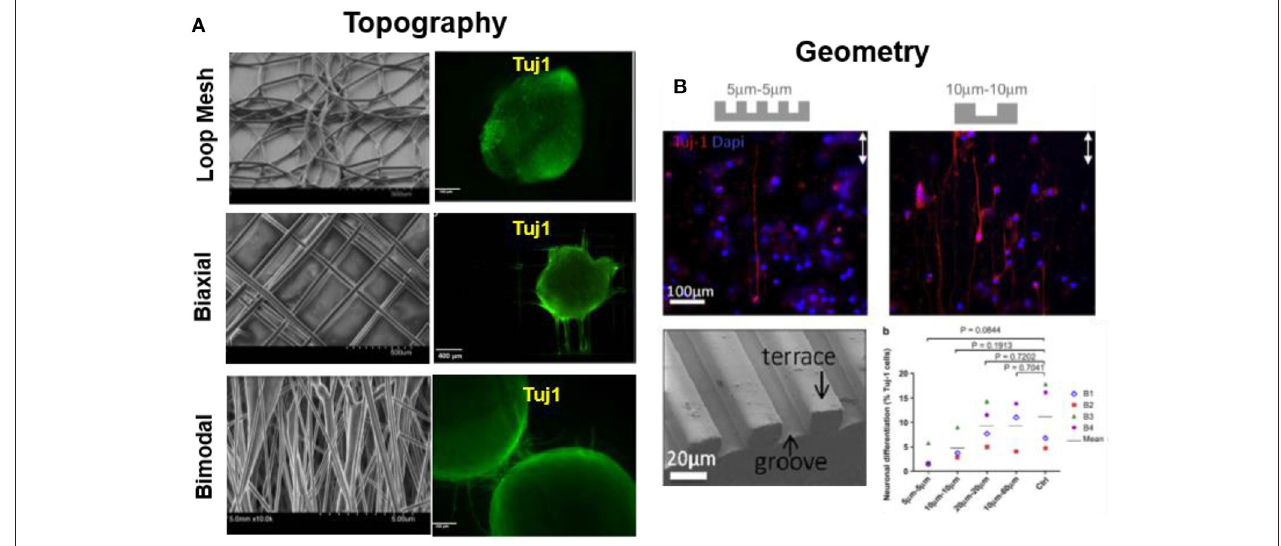
FIGURE 4 | Substrate topography modulates cell differentiation. (A) PCL loop mesh, bimodal and biaxially aligned electrospun scaffold (fiber diameter ∼ 40–85 µ m) influence on differentiation of iPSCs. Biaxially aligned fibers preferentially promoted the highest neurite extension as labeled by Tuj1 immunostaining ( Mohtaram et al., 2015) Copyright 2015, John Wiley and Sons; (B) Micro-patterned PDMS with PL and LN stripes directed differentiation and guidance of adult hNSCs. Microstripes > 10 µ m promote neuronal differentiation, while < 10 µ m hinder differentiation, during 7 days of culture (B1-B4 represents individuals with 4 different biopsies) ( Béduer et al., 2012 ) Copyright 2012,